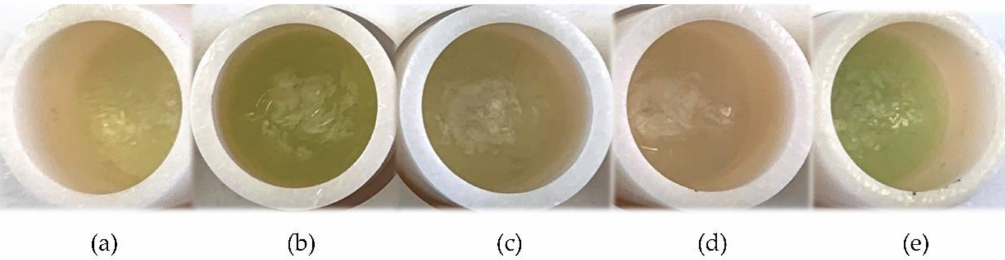
Figure 7. Discoloration of the solar salt in the Haynes214 ( a ), Haynes214 pre-ox. ( b ), LB2230 ( c ), LB2230 pre-ox. ( d ) and Crofer ® 22 H ( e ) containers after 550 h at 600 ◦ C.